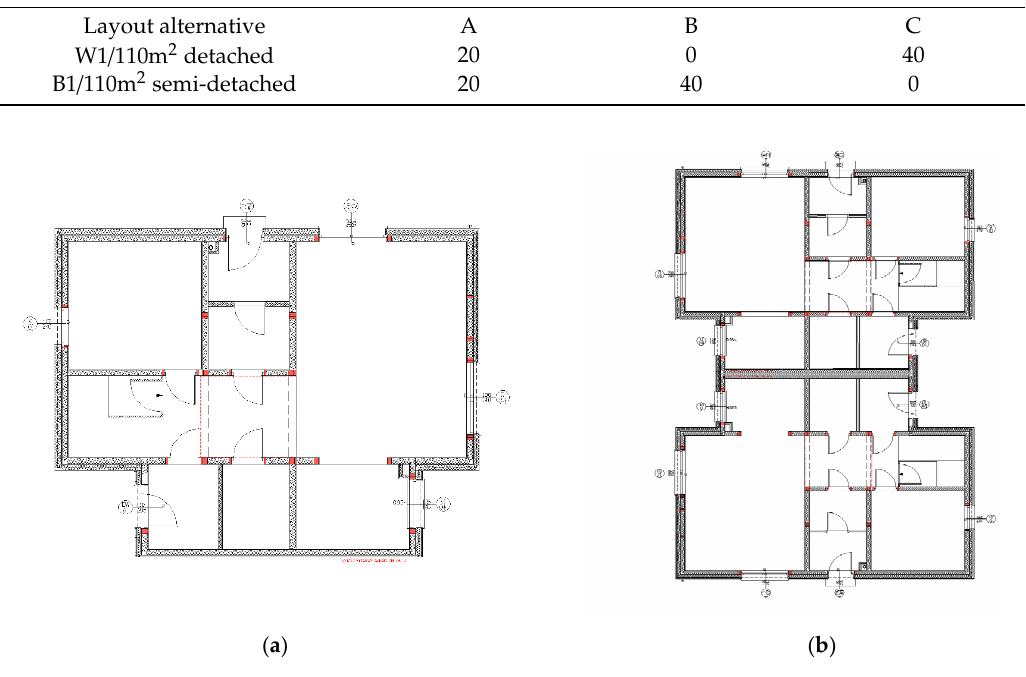
Figure 5. ( a ): Ground floor plan of a detached building with a usable floor area of 110 m 2 (variant W1); ( b ): semi-detached building (variant B1).